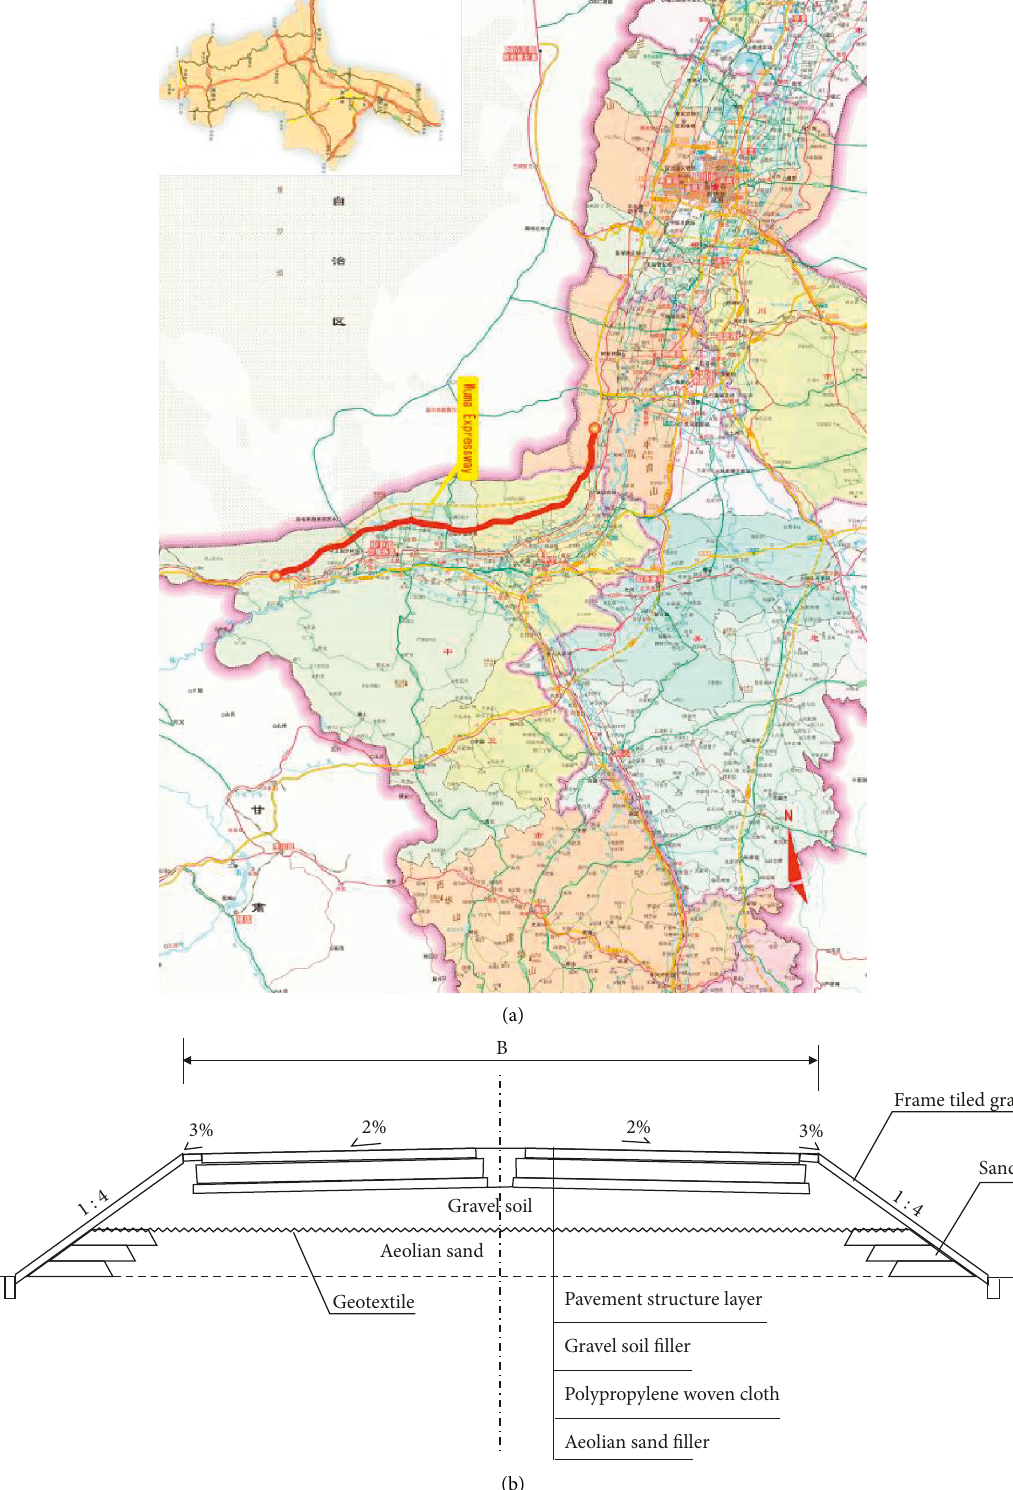
Figure 1: Background information of relying project. (a) Schematic of the location of the section in the study area. (b) Standard cross- section diagram of